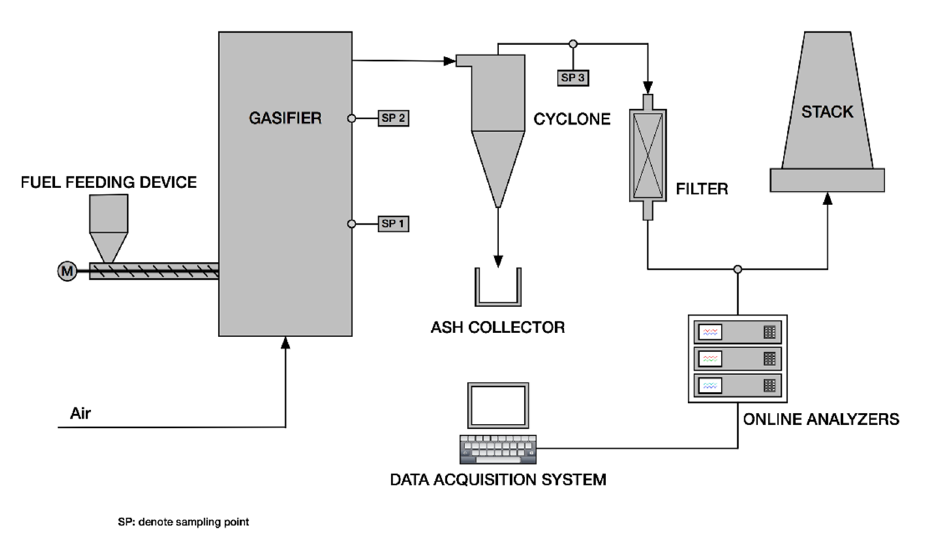
Figure 1. Schematic illustration of the pre-pilot bubbling fluidized bed